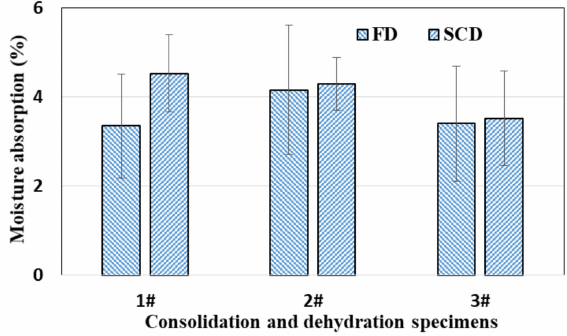
Figure 5. Moisture absorption of specimens from different samples.